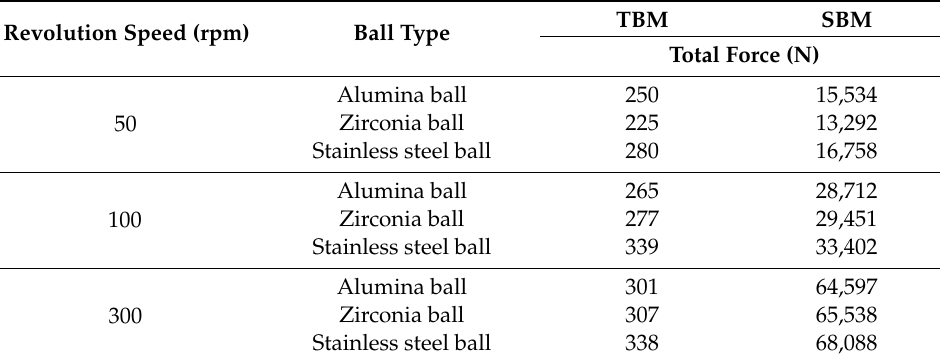
Table 3. Total impact force obtained by DEM simulation in both mills TBM and SBM. Revolution Speed